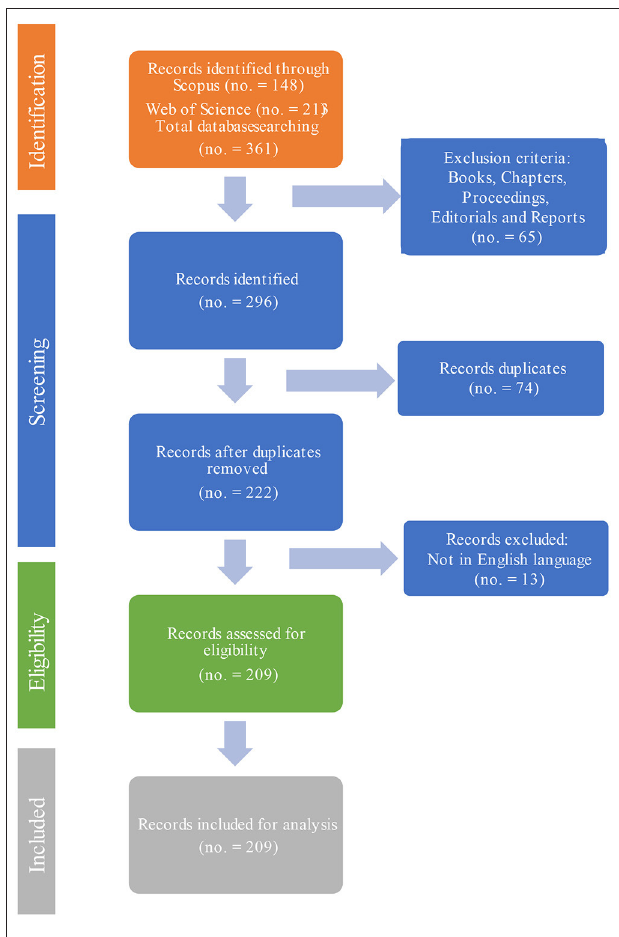
FIGURE 1 | Prisma flow diagram (Source: our elaboration). Keywords (“novel food*” AND